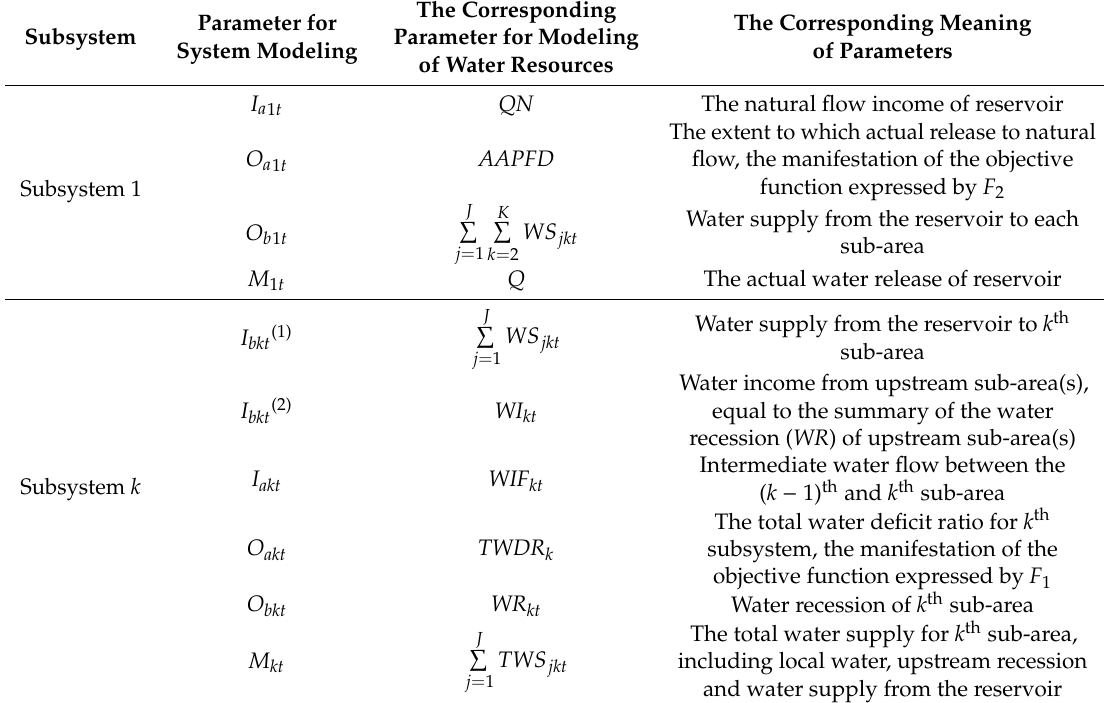
Table A2. The main parameters in large system model of water resources.